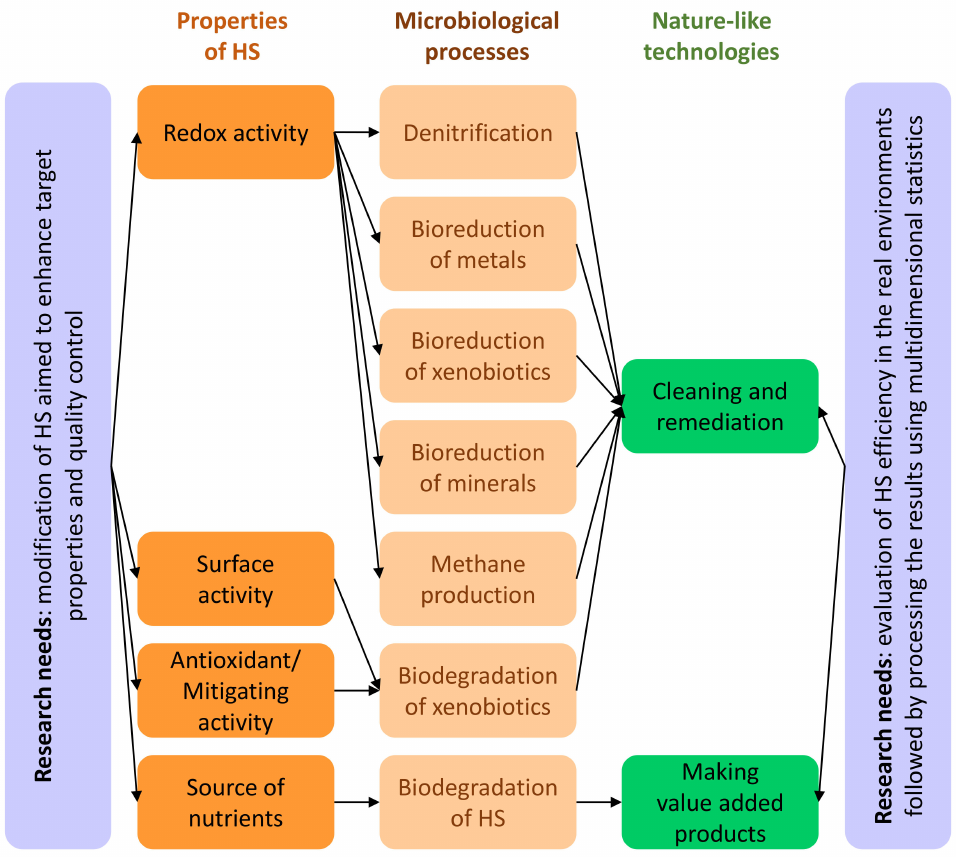
Figure 1. Principal research needs for microorganism–HS interactions that can support the develop- ment of nature-like